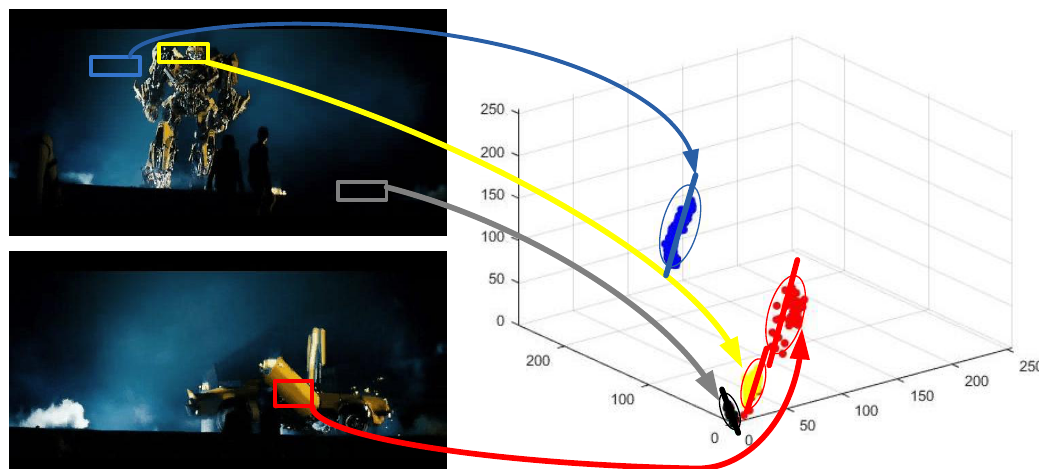
Figure 3. Scatter plot of three different regions, which are represented by blue yellow and black arrow respectively. The red arrow represents the foreground region in different illumination. The directional vectors of hyperlines that represent the foreground in different illuminations are approximately the same, as shown by the red